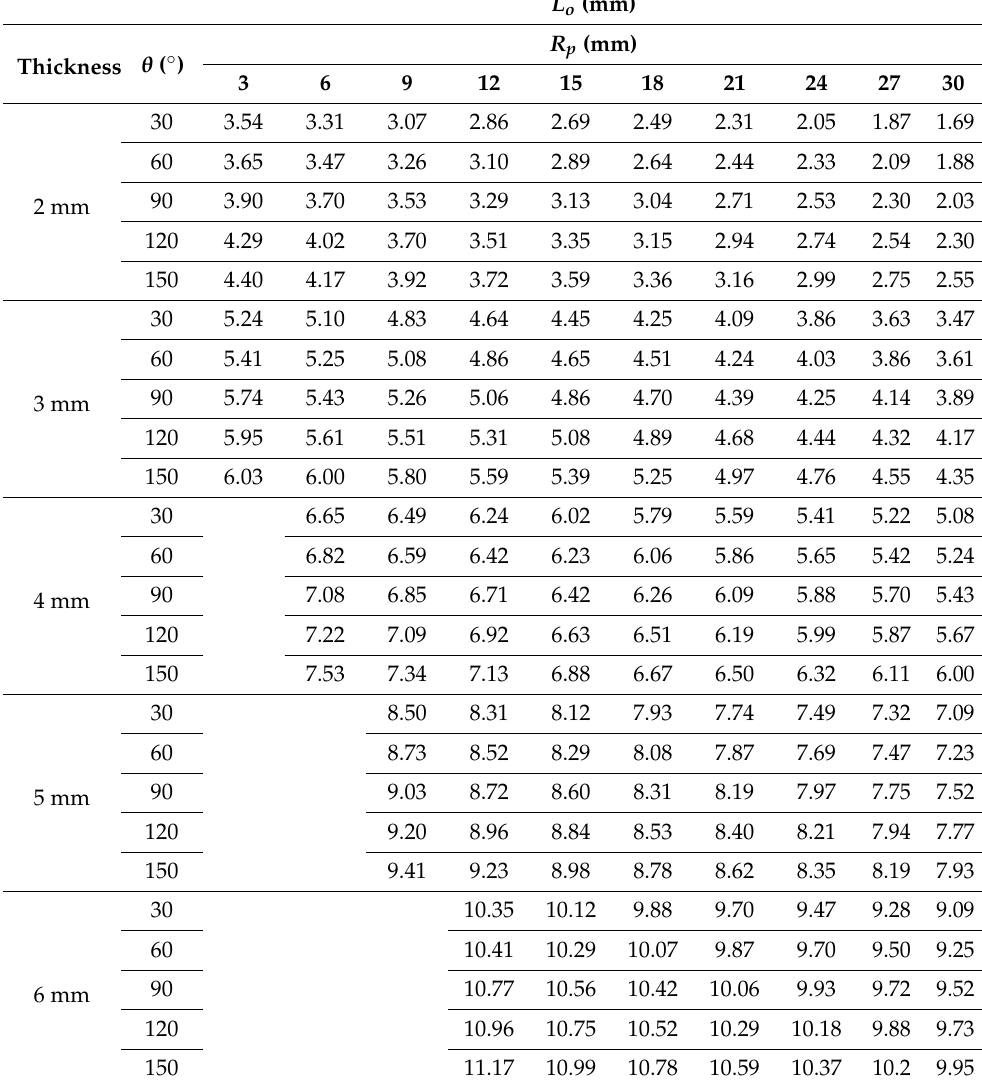
Table 2. Recommended length of reversed bending allowance zone on legs ( L o